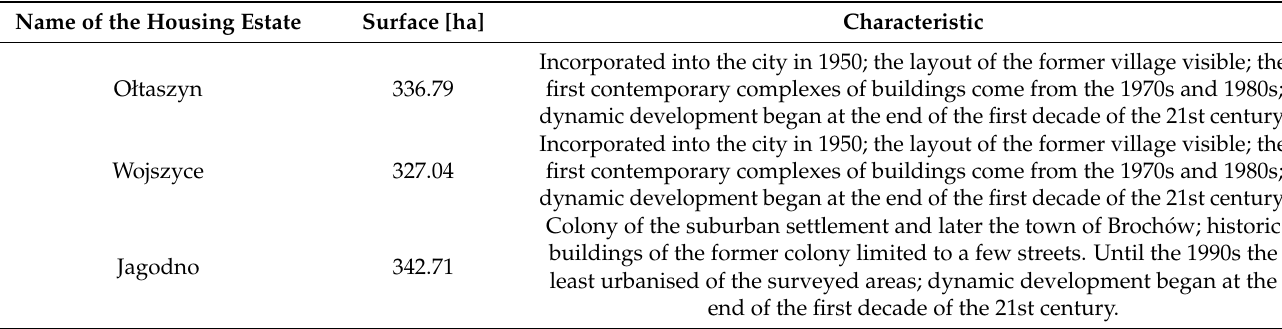
Table 1. Characteristics of housing estates located in the study